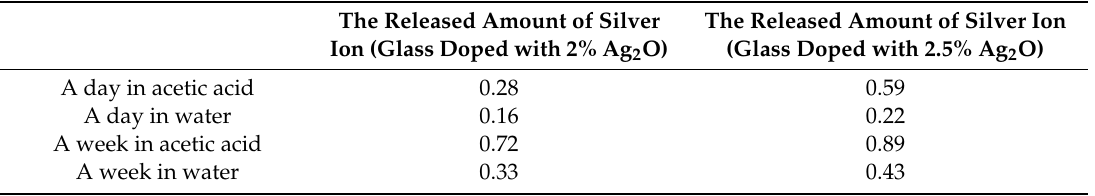
Table 3. Inductively coupled plasma-mass spectrometer (ICP-OES) test